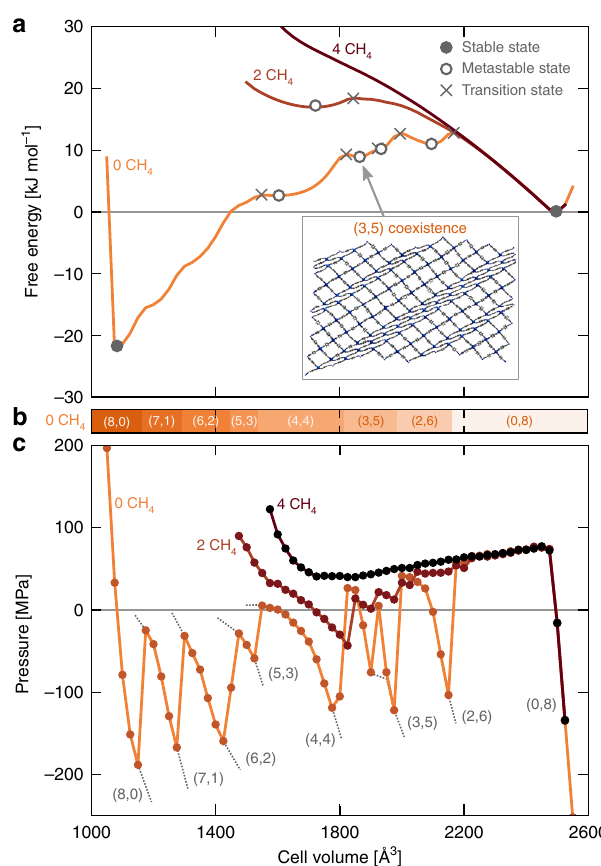
Fig. 6 Using guest adsorption as a stimulus to access the metastable cp/lp coexistence regions in CoBDP. a Free energy and c pressure equations of state at loadings of 0, 2, and 4 methane molecules per conventional unit cell, with b indication of the metastable ( n , n ) phase coexistence regions cp lp as a function of the volume for the empty framework for an 8 × 2 × 8 mesocell of CoBDP at 300 K. The different (meta)stable states and transition states are indicated on the free energy equations of state with (open) circles and crosses,